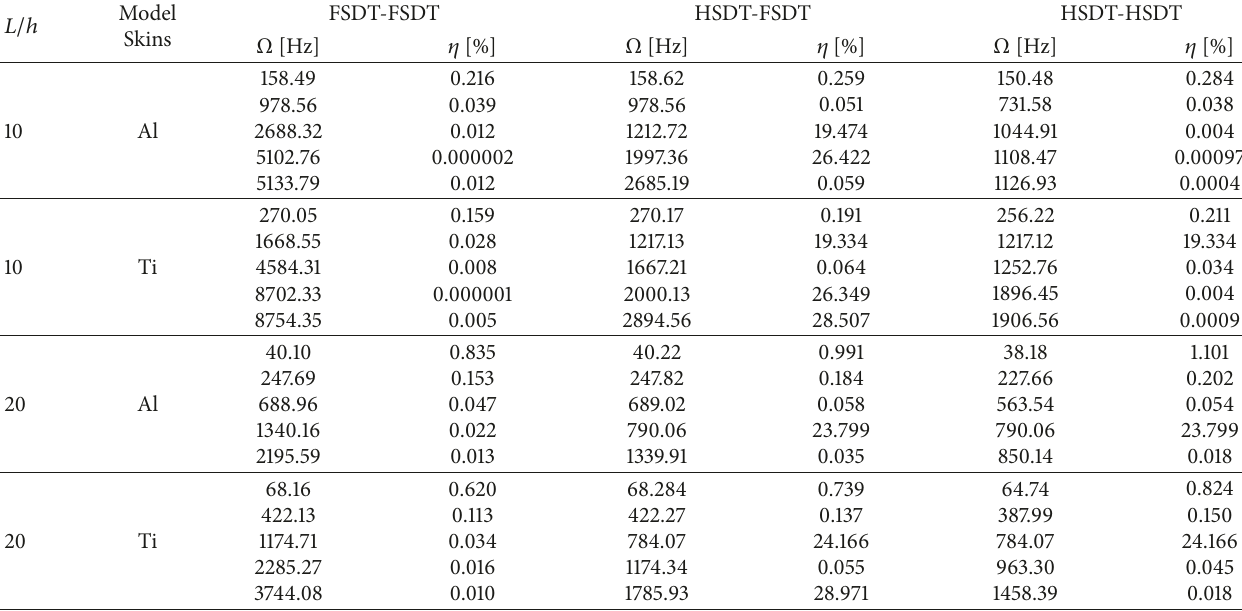
Table 13: Frequency Ω and loss factors 𝜂 (Hz). 𝑤 GNP = 2.5